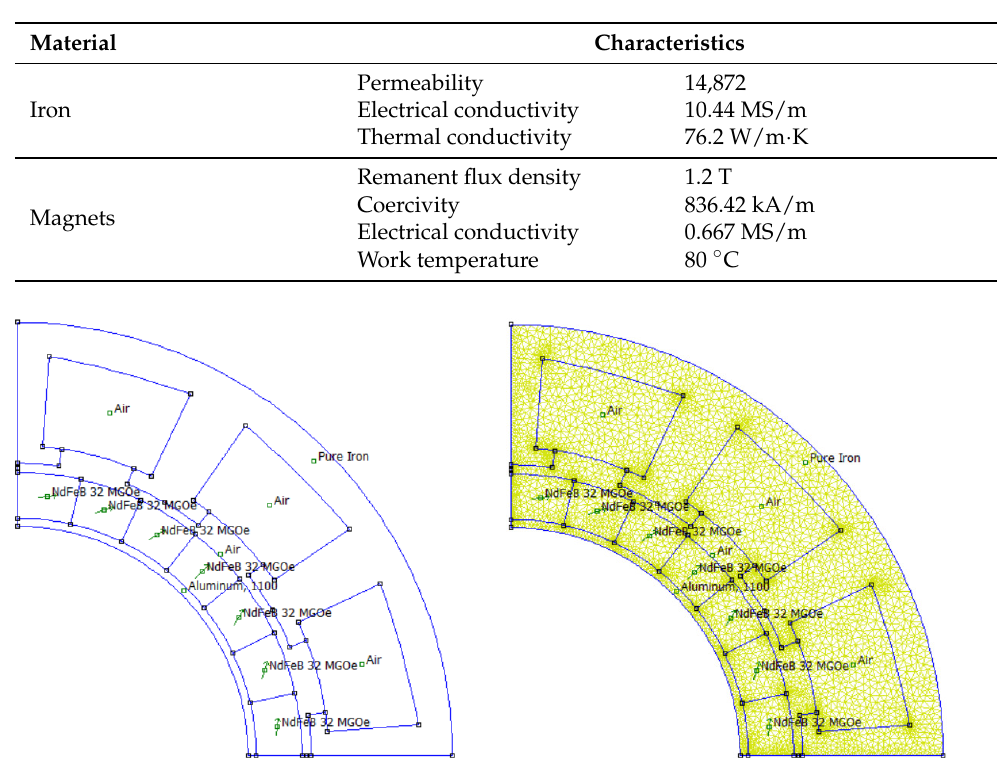
Table 7. Material Characteristics.